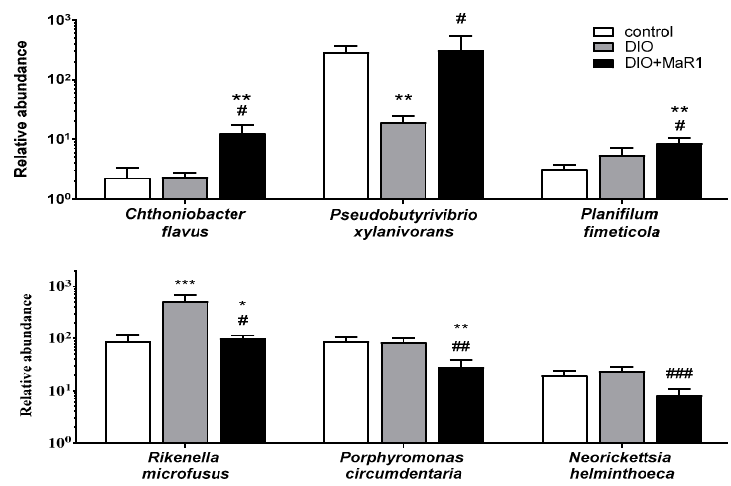
Figure 4. Relative abundance of species C. flavus , P. xylanivorans , P. fimeticola R. microfusus , P. circumdentaria, and N. helminthoeca in gut microbiota of the control and DIO mice treated, or not treated, by oral gavage with MaR1 (50 μ g/kg/day) for 10 days. Data are expressed as mean ± SE ( n = 7–8). * p < 0.05, ** p < 0.01, *** p < 0.001 vs. control and # p < 0.05, ## p < 0.01, ### p < 0.001 vs.